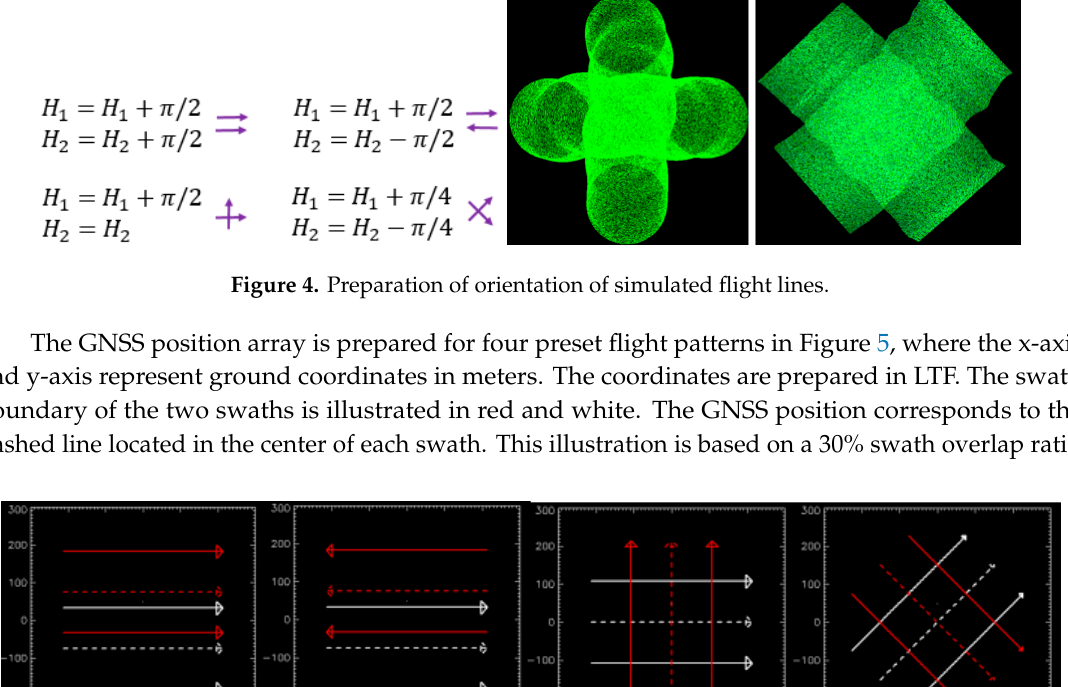
Figure 5. Preset flight patterns of the airborne lidar simulator.